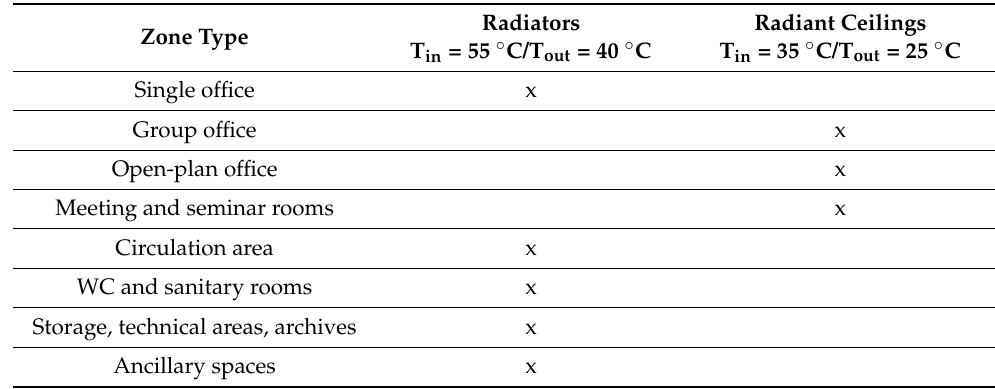
Table 3. Heat distribution systems used for the energy